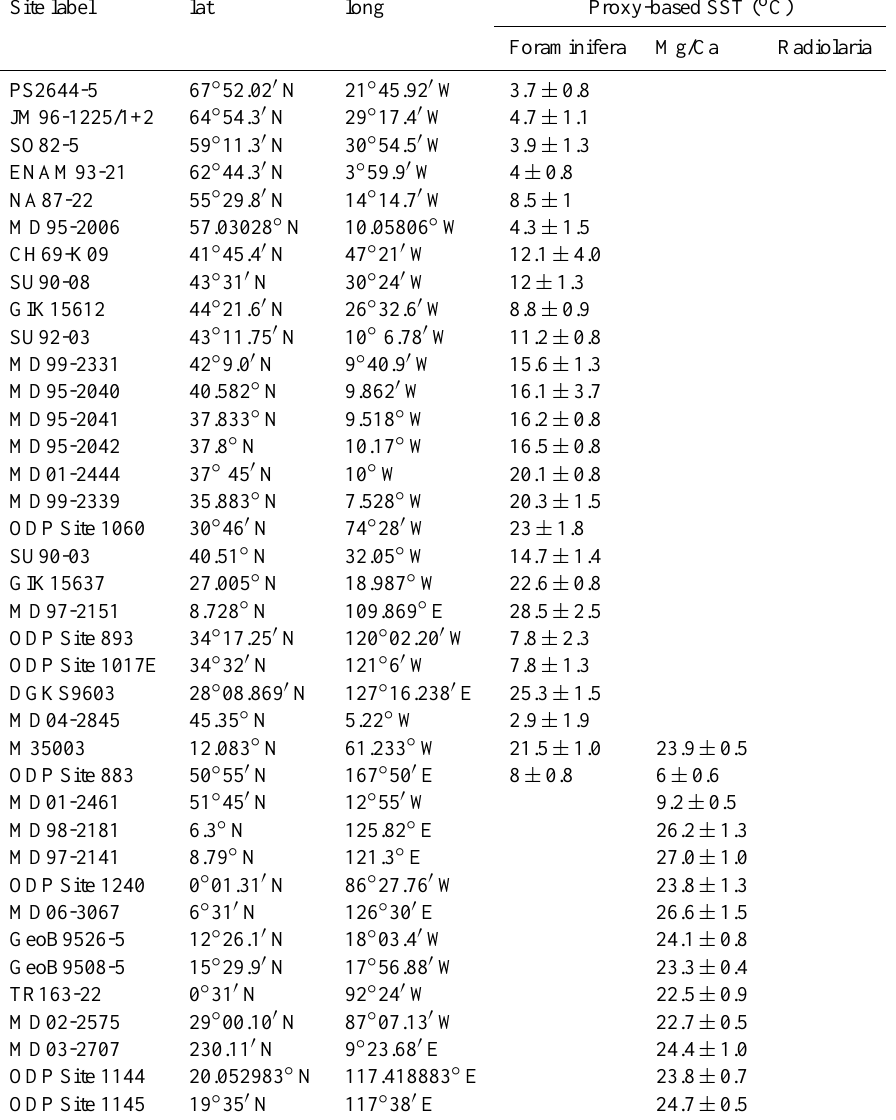
Table A7. Proxy based SST data for Northern Hemisphere summer (July–September) mean conditions with ± 1 σ error (given either by the author(s) of the respective data or estimated by the authors of this